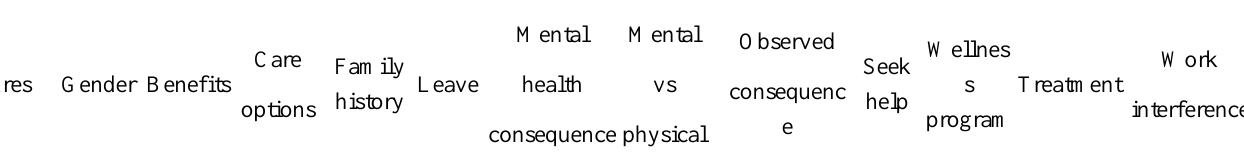
Table 3 Bootstrap estimates of Guttman correlation coefficient µ2. Bold represents moderate, and italics represent a strong correlation between a feature and MI,